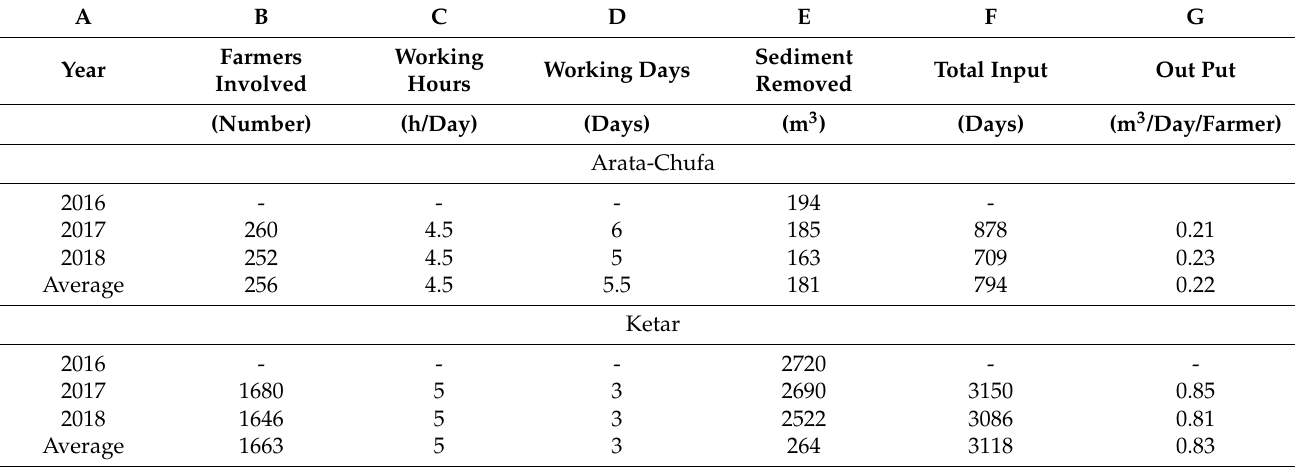
Table A1. Labour input and sediment output of the Arata-Chufa and Ketar irrigation scheme: adopted from Gurmu et al., 2019.